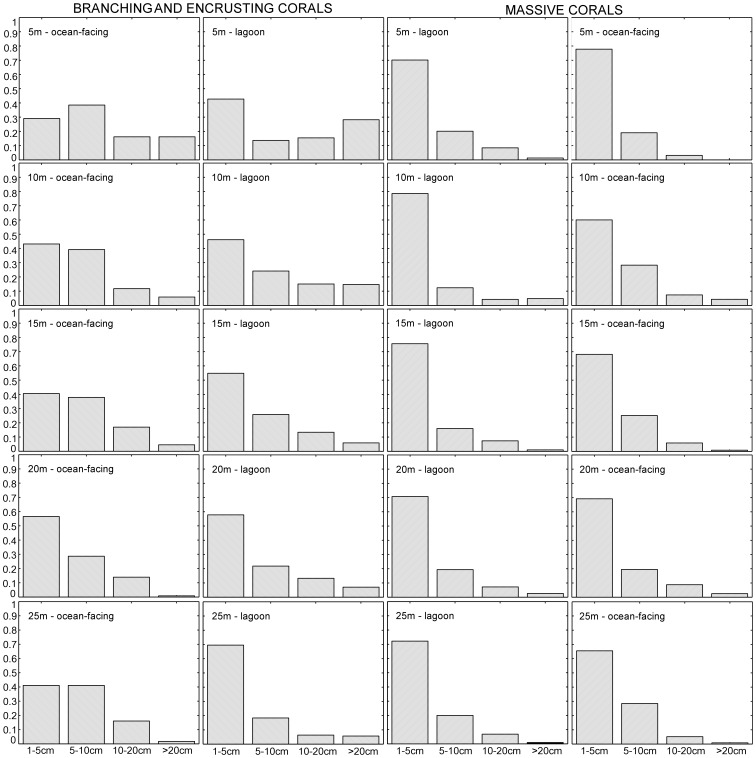
Size distribution of corals in the Chagos.Branching, encrusting and arborescent corals are pooled, since arboresecent corals only occur in specific environments. Values are based on sums of all measured corals in all transects in each environment. The fifth size-class used in models is spat, which cannot be adequately counted in phototransects.